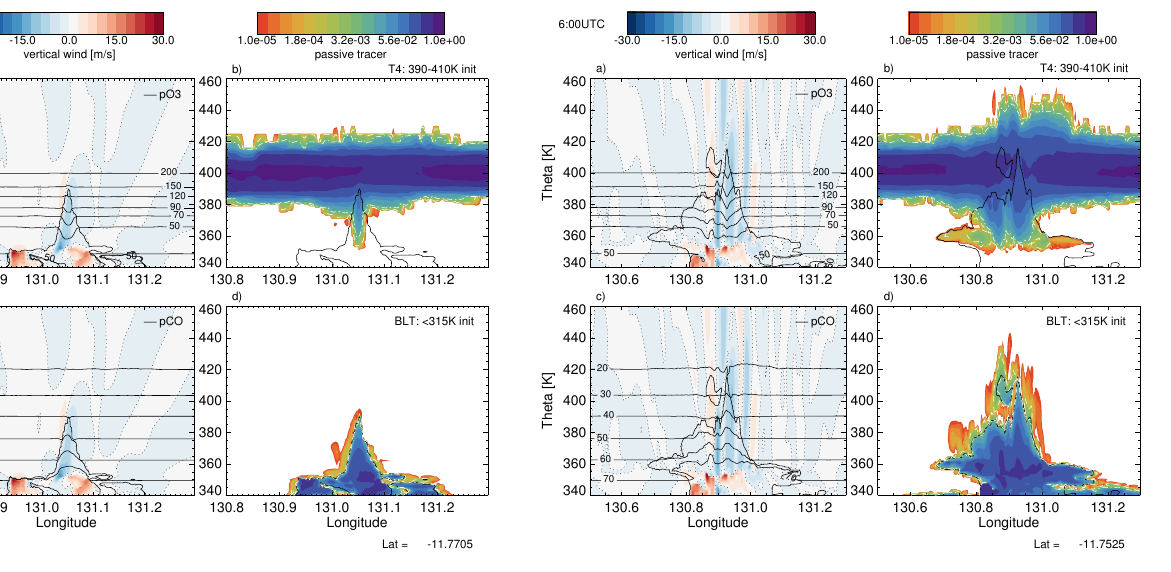
Figure 9. Same as Fig. 8 but for